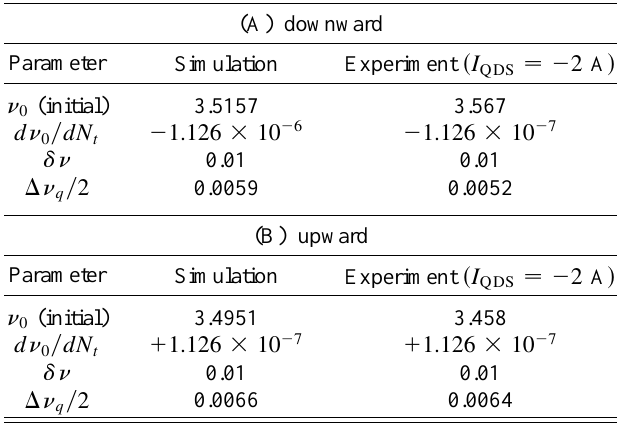
TABLE III. The conditions of the resonance cross experiments and multiparticle